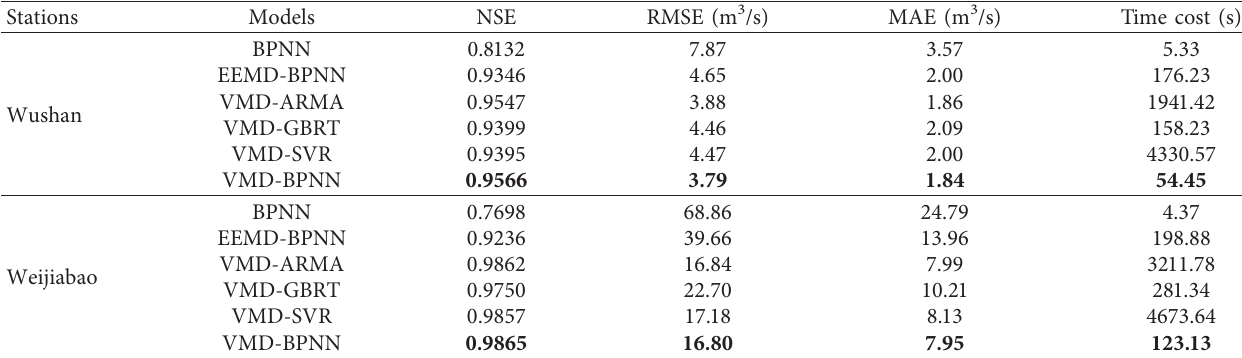
Figure 9: Comparison of scatter plots between the observed and simulated streamflows from the BPNN, EEMD-BPNN, VMD-ARMA, VMD-GBRT, VMD-SVR, and VMD-BPNN models during the testing phase (01/01/2012–31/12/2014) at the Weijiabao station. Table 8: The performance of the different prediction models during the testing period for the Wushan and Weijiabao hydrological stations in the Wei River